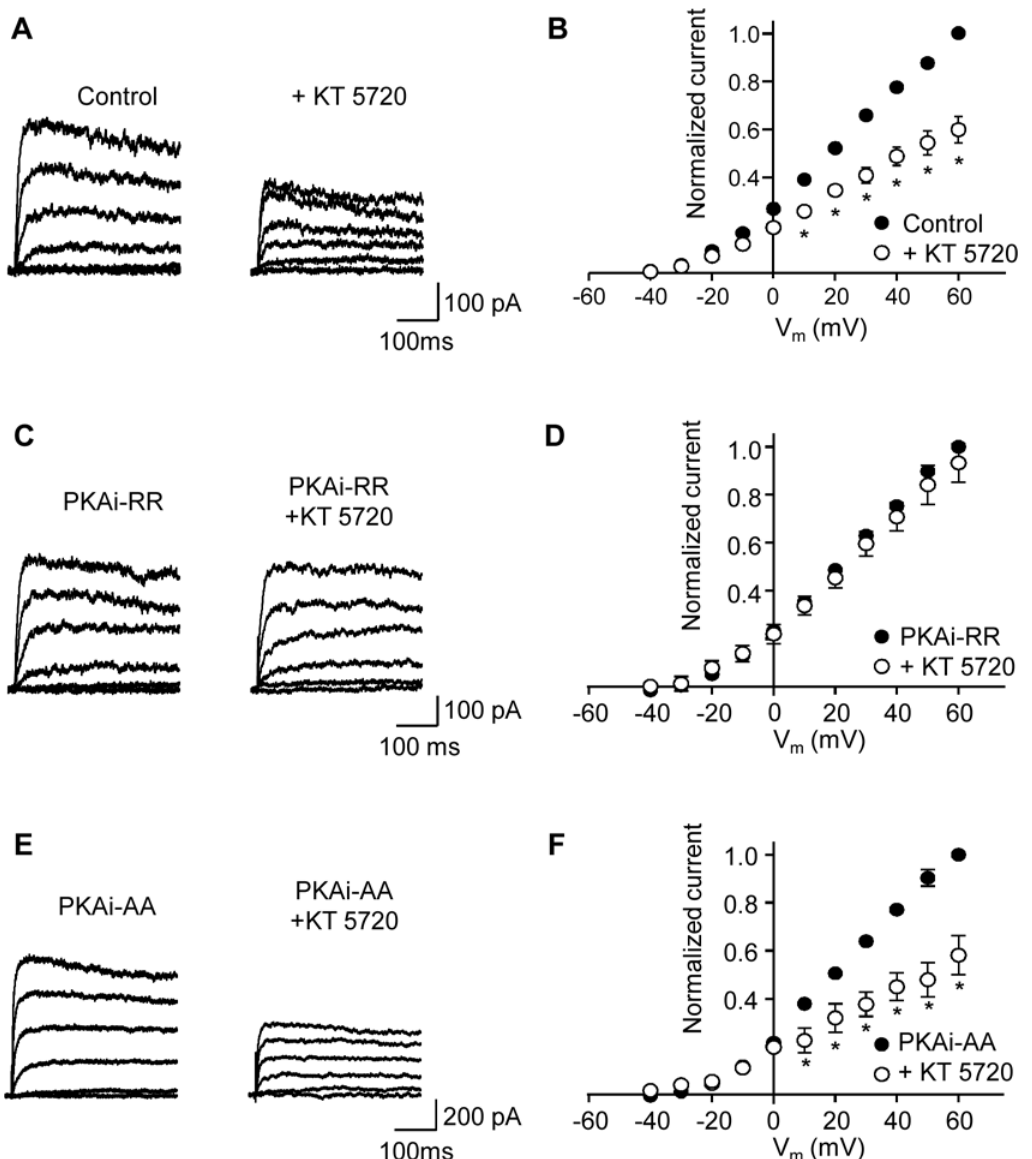
Fig 1. Inhibition of PKA attenuates K v current. K v currents were activated in response to 400 ms depolarizing voltage steps from a holding potential of -65 mV. ( A ) Representative K v current traces before (control) and after application of 1 μ M KT 5720 as indicated. Representative K v currents shown in this and subsequent figures are in 20 mV increments beginning from -40 mV. ( B ) Mean ( ± s.e.m.) I-V plots (normalized to control current at +60 mV) before and after application of 1 μ M KT 5720 (n = 8 cells). ( C ) Representative K v current traces before and after application of 1 μ M KT 5720 obtained in the presence of the PKA inhibitor peptide, PKAi-RR (5 μ M) in the patch pipette. ( D ) Mean ( ± s.e.m.) I-V plots (normalized to the control currents, i . e . in the presence of PKAi-RR, at +60 mV) before and after application of 1 μ M KT 5720 as indicated (n = 5). ( E ) Representative K v current traces before and after application of 1 μ M KT 5720 in the presence of PKAi-AA (5 μ M), an inactive isoform of PKAi-RR, in the patch pipette. ( F ) Mean ( ± s.e.m.) I-V plots (normalized to the respective control currents, i . e . in the presence of PKAi-AA at +60 mV) before and after application of 1 μ M KT 5720 as indicated (n = 7). * P < 0.05; two-way ANOVA, Bonferroni ’ s post hoc test.